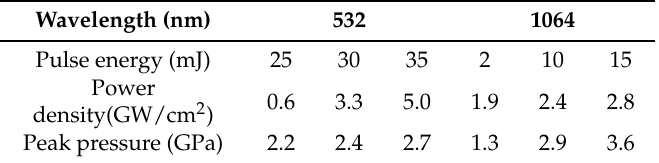
Table 6. Estimated values of peak pressure for different pulse energies at two different